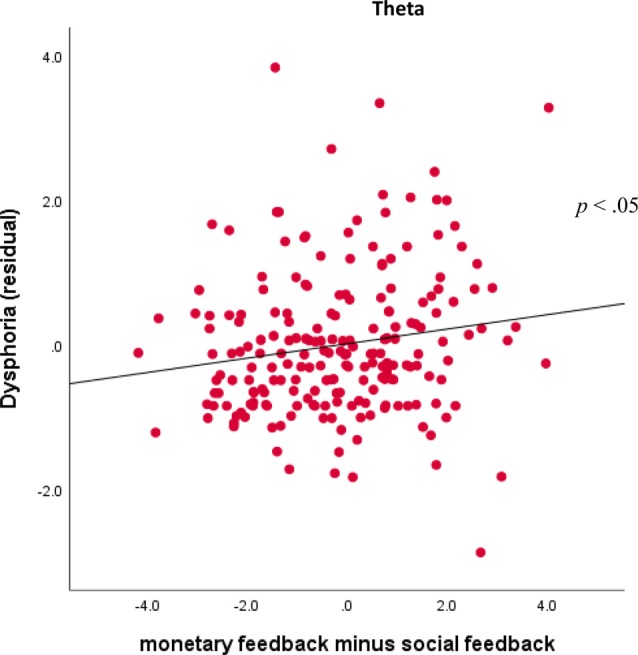
Associations between TF4SF1 (theta activity) for monetary feedback and symptoms. Scatterplots displaying the associations between theta activity for monetary feedback (averaged across valence and outcome) subtracting social feedback (averaged across valence and outcome) and dysphoria symptoms.